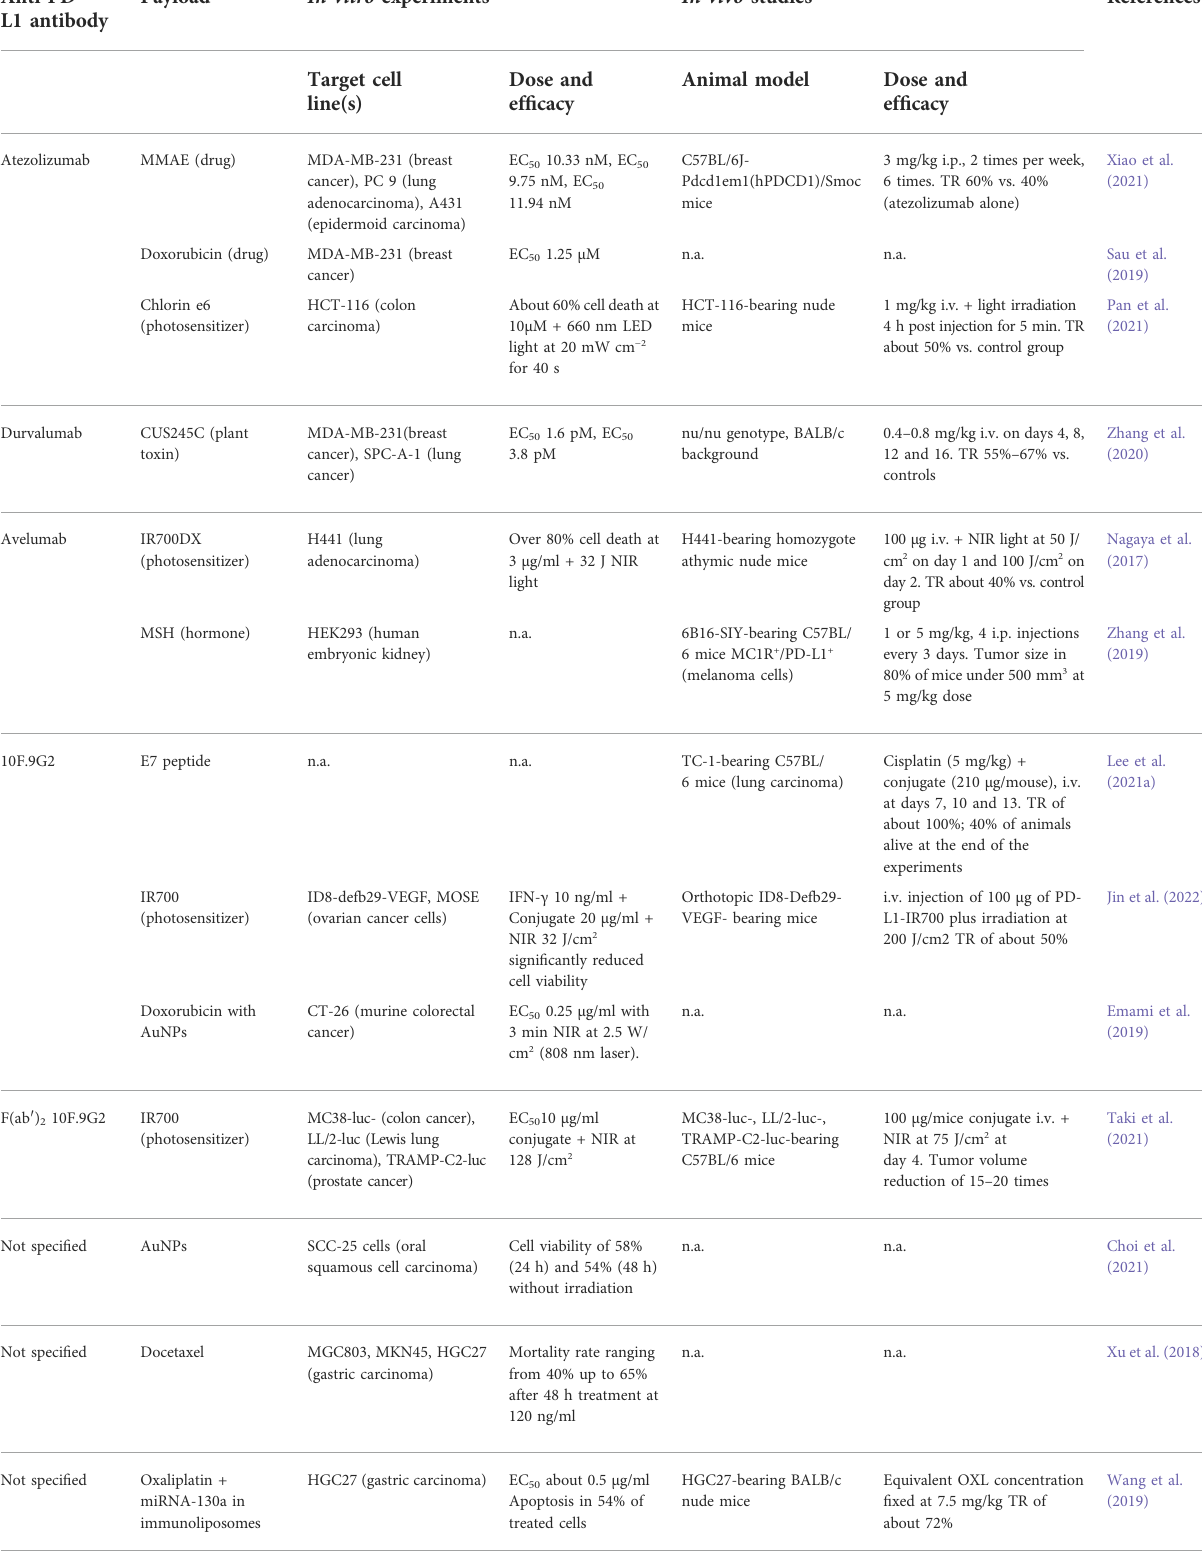
TABLE 1 In vitro and in vivo experiments carried out with anti-PD-L1